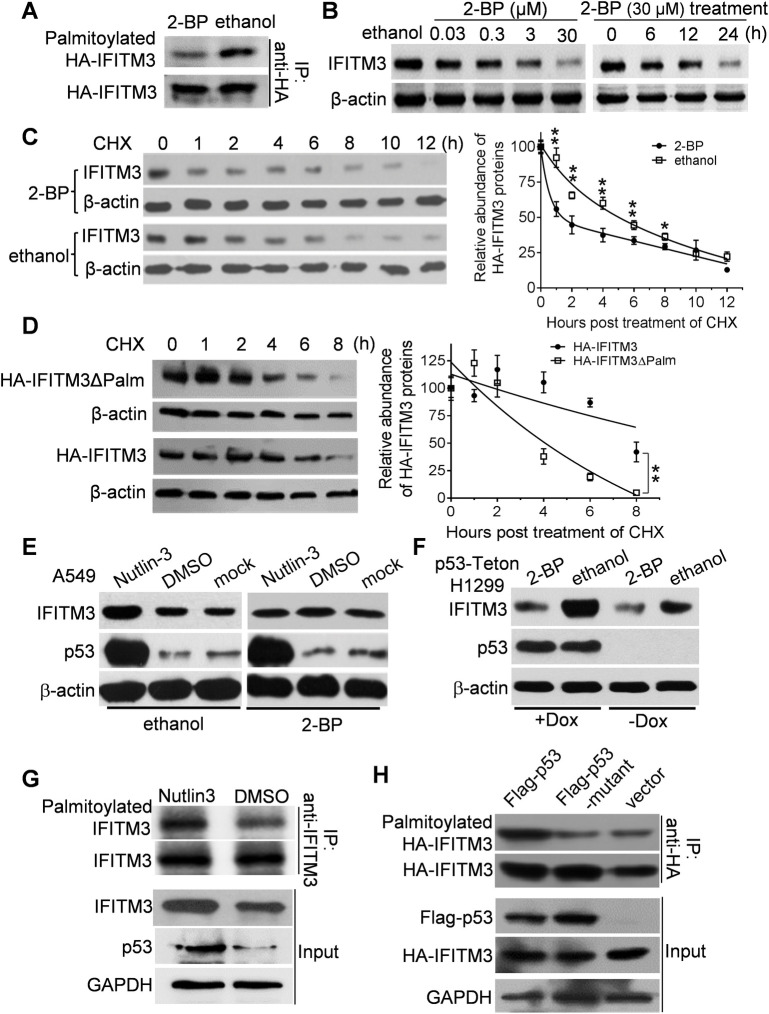
The essential role of p53 controlling IFITM3 palmitoylation for its protein stability.(A) HEK293 cells were transfected with HA-IFITM3 plasmid for 36 h and then treated with 30 μM 2-BP for 24 h, palmitoylated HA-IFITM3 level was measured with palmitoylation assay. (B) A549 cells was treated with 2-BP at different dose for 24 h (left panel) or 30 μM 2-BP for different times (right panel), IFITM3 expression was detected with western blot. (C) HCT116 cells were treated with 30 μM 2-BP or equivalent ethanol for 24 h and subsequently subjected to CHX chase assay. The cells were harvested at the indicated times for western blot analysis (left panel), and relative IFITM3 protein levels normalized to β-actin were presented relative to the level (set as 100) at 0 h post-CHX treatment (right panel). (D) HCT116 cells were transfected with plasmids expressing HA-IFITM3 or HA-IFITM3ΔPalm for 36 h and subsequently subjected to CHX chase assay as above. (E) A549 cells were treated with 20 μM Nutlin-3 in the presence of 30 μM 2-BP or equivalent ethanol for 24 h, IFITM3 and p53 expression were detected by western blot. (F) p53-Teton H1299 cells were treated with 1 μg/ml Dox in the presence of 30 μM 2-BP or equivalent ethanol for 24 h, IFITM3 and p53 expression were detected by western blot. (G) A549 cells were treated with 20 μM Nutlin-3 for 24 h, followed by labelling with 25 μM 17-ODYA for 4 h. The endogenous palmitoylated IFITM3 level was measured with palmitoylation assay. (H) Flag-p53 or Flag-p53-mutant were cotransfected with HA-IFITM3 expressing plasmid into HEK293 cells for 48 h, followed by labelling with 25 μM 17-ODYA for 4 h, then exogenous palmitoylated IFITM3 level was measured with palmitoylation assay. Unpaired t test, *P<0.05; **P<0.01.